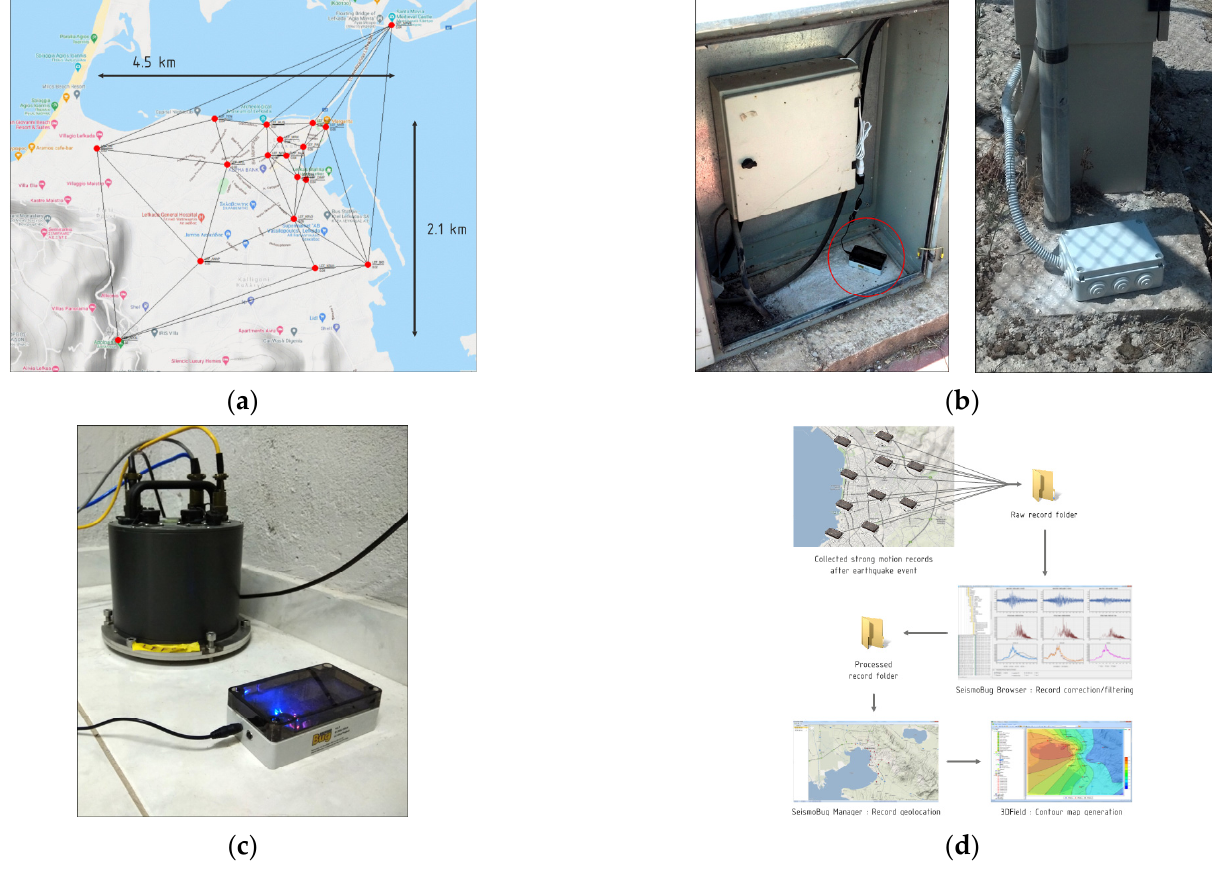
Figure 7. The deployed ultra-dense network ( a ) installation locations ( b ) free-field installation ( c ) basement installation ( d ) outline of the data collection, postprocessing and mapping procedure.